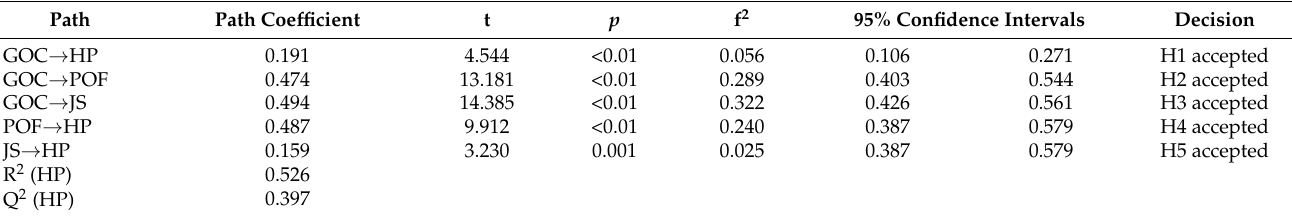
Table 5. Structural relationship and hypothesis